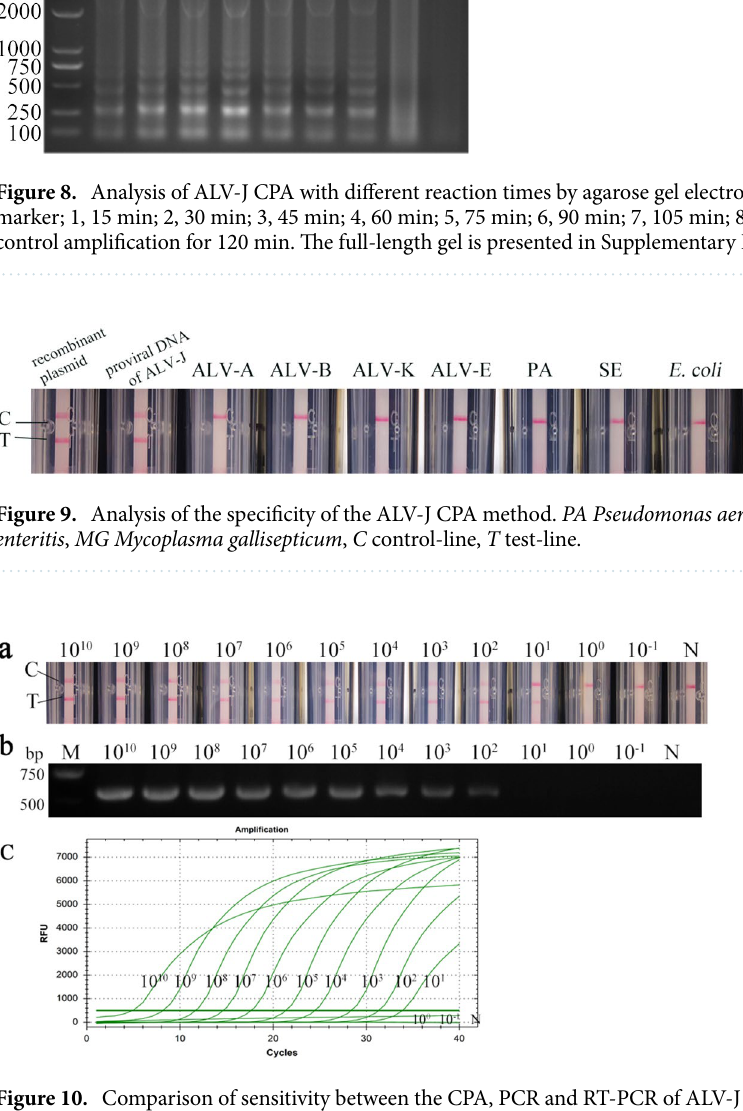
Figure 10. Comparison of sensitivity between the CPA, PCR and RT-PCR of ALV-J detect methods based on recombinant plasmid standards at 1.86 × 10 –1 ~ 1.86 × 10 10 copies μL −1 (a representative image of the three independent) ( a ) Sensitivity of CPA based on a nucleic acid detection device; ( b ) Sensitivity of conventional PCR; The full-length gel is presented in Supplementary Figure S25. ( c ) Sensitivity of RT-PCR for ALV-J. C, control-line; T, test-line; N, negative